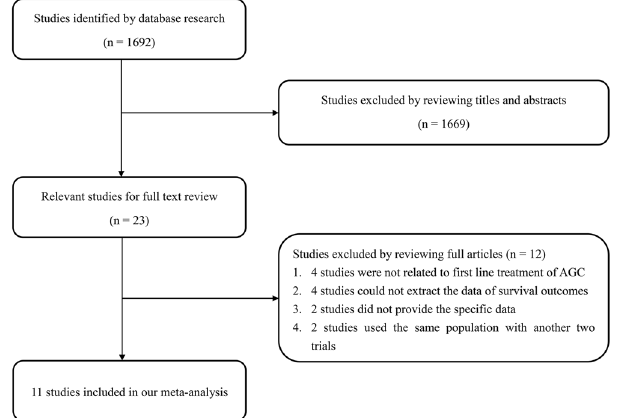
Figure 1. The flow chart of studies